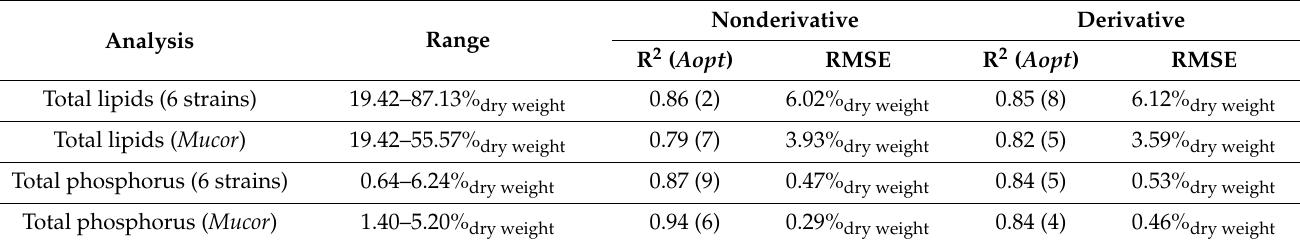
Table 3. PLSR coefficients of determination (R 2 ) and root mean square errors (RMSE) for determination of total lipids and phosphorus, with the number of components in parenthesis ( Aopt ), for the regression analyses based on nonderivative and derivative preprocessed FTIR